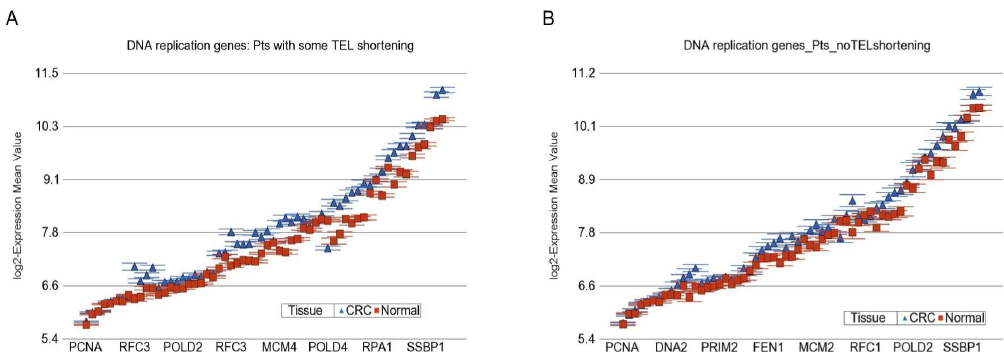
Figure 8. Differential expression of genes involved in “DNA replication” in CRC tissue (in blue) compared to corresponding normal tissue (in red). The gene probes (multiple probes for some genes) are shown on the x-axis, and the Log2-transformed expression value is shown on the y-axis. Data from patients with RTL shortening are shown on the left ( A ), and data from patients without RTL shortening are shown on the right ( B ).